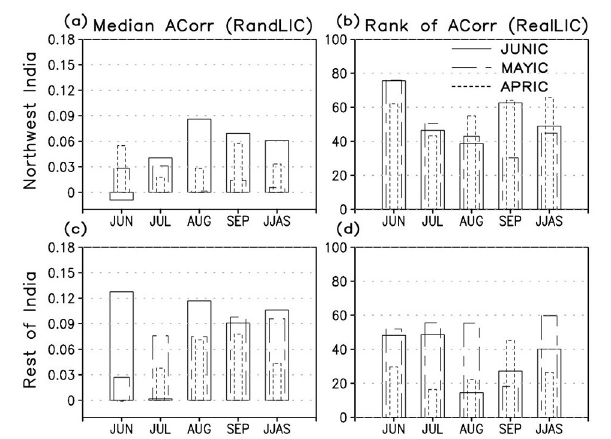
FIGURE 12 | (a) median anomaly correlation of root zone soil moisture based on CFSv2 JUNIC, MAYIC and APRIC hindcasts with RandLIC and GLDAS2, in each month and JJAS, averaged over the northwest of India. (c) shows the same for the rest of India region. (b,d) depict the percentage area that shows RealLIC anomaly correlations in the upper quartile of the 28 ensemble members, for each month and JJAS, for the northwest and rest of Indian domains,